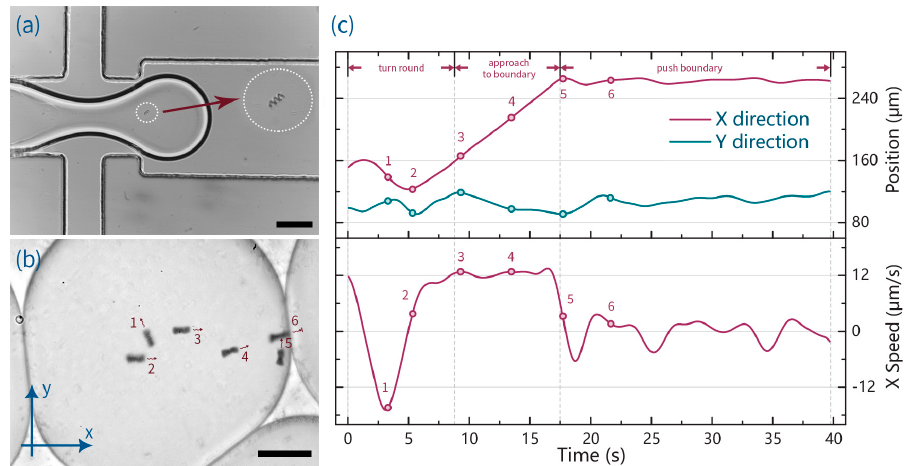
Figure 2. ( a ) Image showing the formation of an ABF-containing droplet. The ABF is shown within the white dotted circle; ( b ) A time-lapse image showing controlled locomotion of an ABF within a droplet. The magnetic field is 90 Hz and 9 mT; ( c ) Variation of ABF position and speed for experiment shown in (b). The upper plot illustrates the x , y position as a function of time and the lower plot shows the variation of velocity in the x direction. It is noted that when the ABF reaches the droplet boundary (at 17.5 s), the net displacement and average speed in x are both zero. Scale bars correspond to 100 µm.